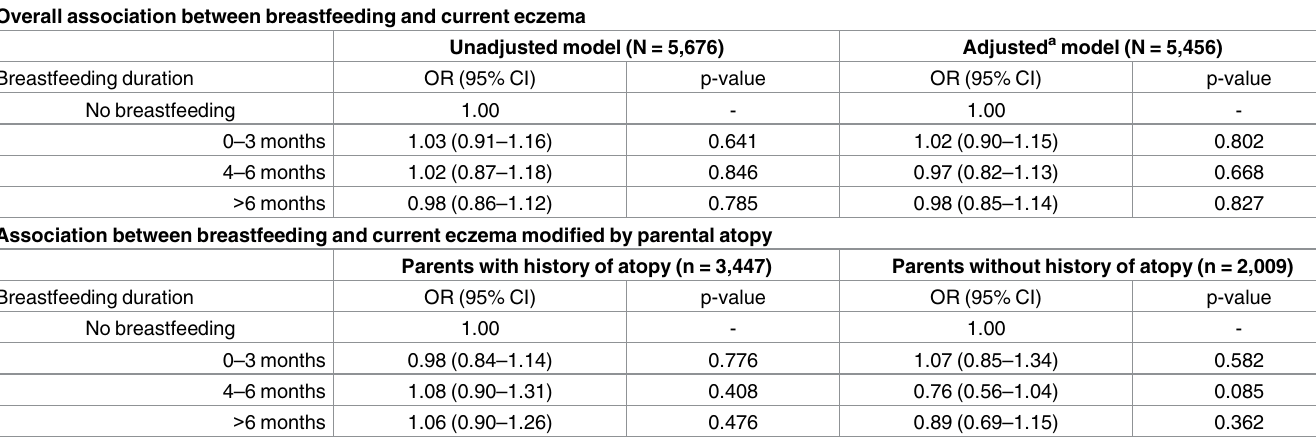
Table 2. Association between breastfeeding duration and prevalenceof current eczemaduring childhood and adolescence. Overall association between breastfeeding and current